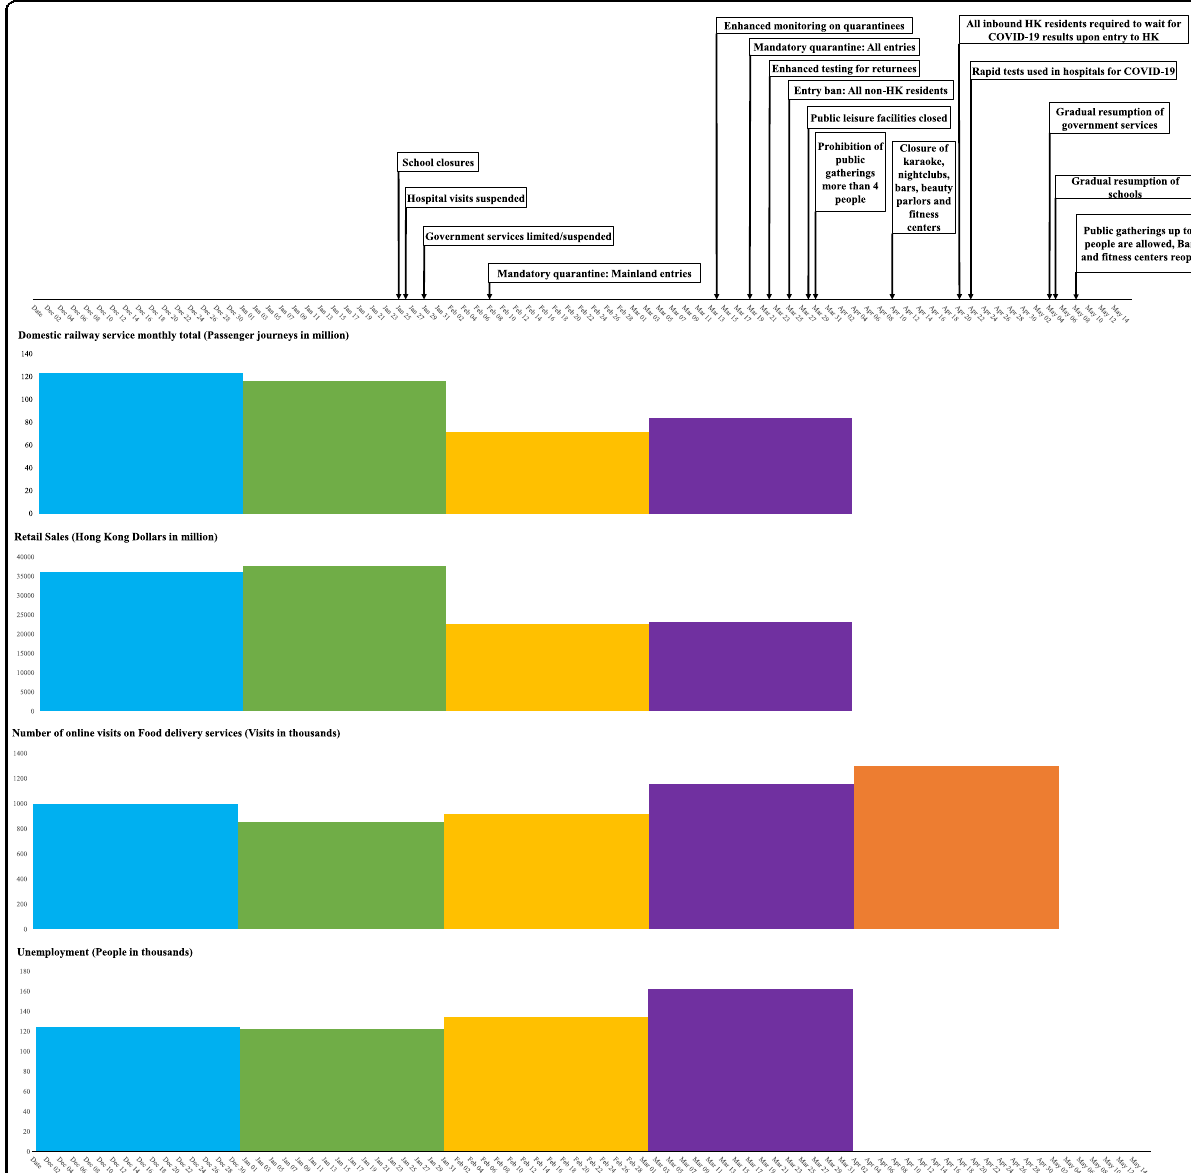
3 = nearly every day). Higher scores indicated greater severity of anxiety symptoms. The measure showed high internal consistency (Cronbach ’ s α = 0.92) and has been